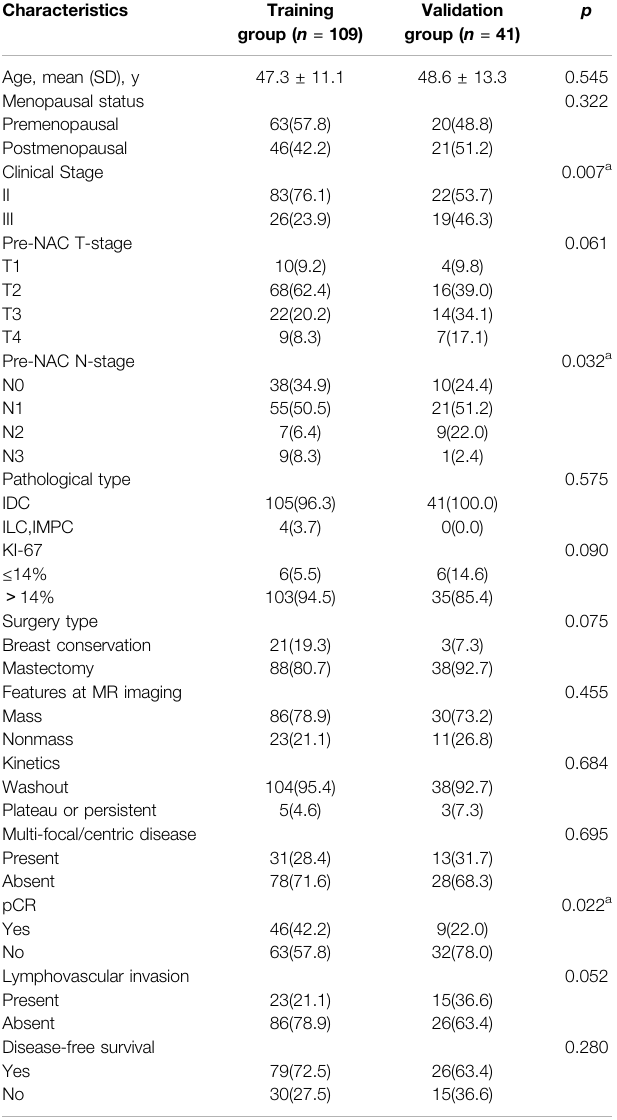
TABLE 2 | Comparison of clinical and pathological and pretreatment MR imaging characteristics between training and validation groups. Characteristics